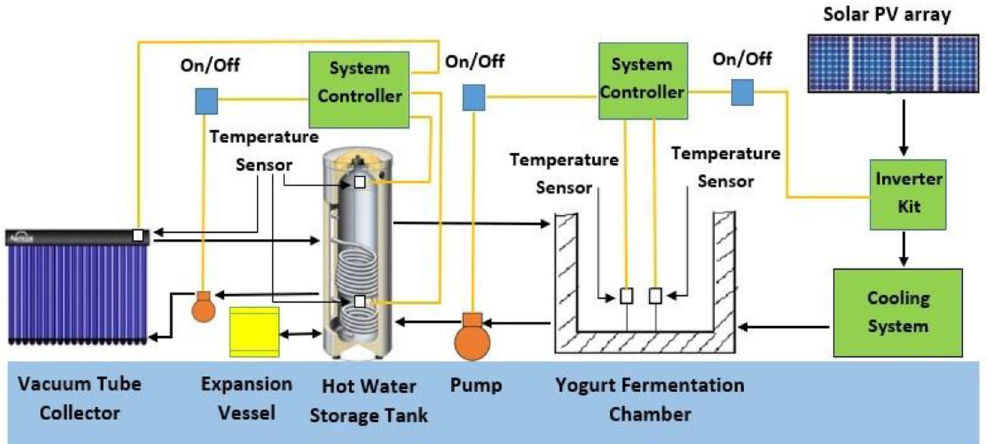
Figure 2. Experimental setup layout of solar assisted yogurt processing unit 20